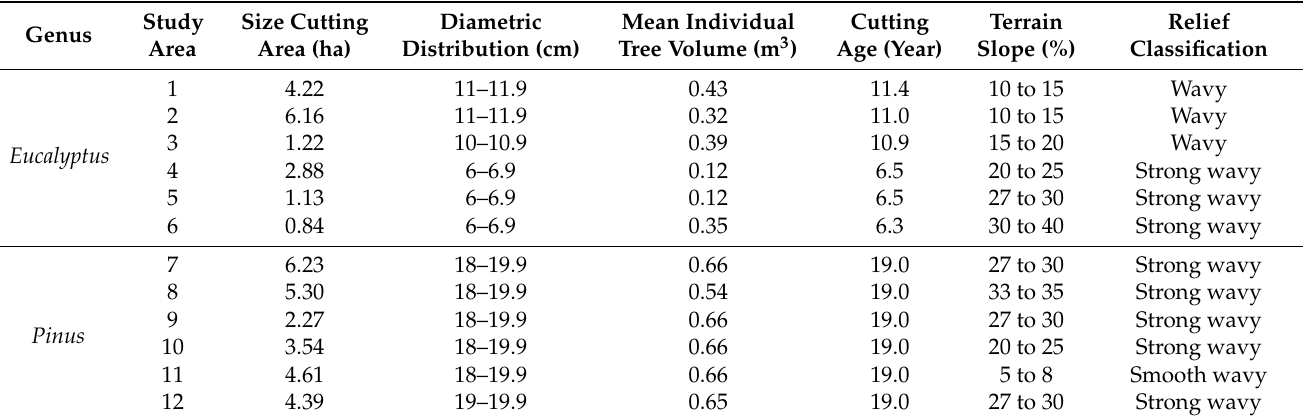
Table 1. Study area